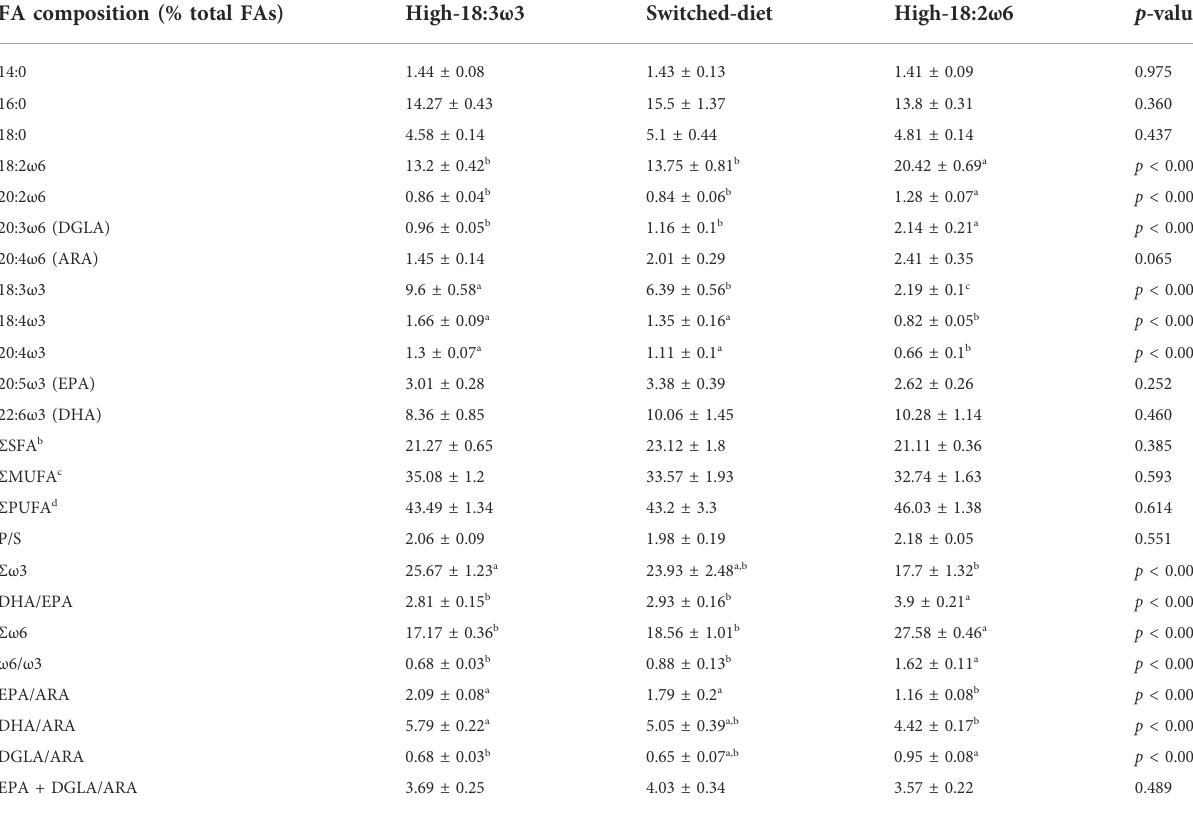
TABLE 3 Fatty acid pro fi les (% total FAs a ) of the head kidney tissues of Atlantic salmon after 8 weeks of the experimental diet